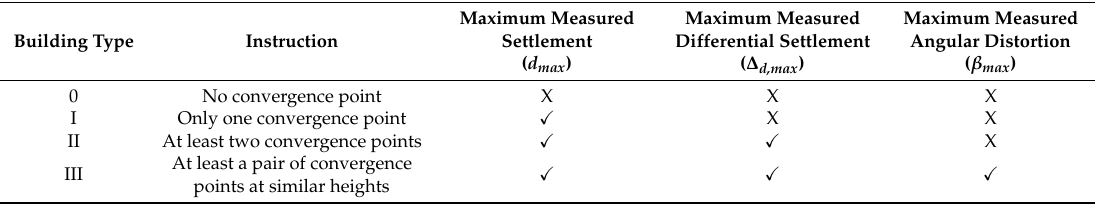
Table 1. Different building categories depending on the deformation information provided by satellite synthetic aperture radar interferometry (InSAR)